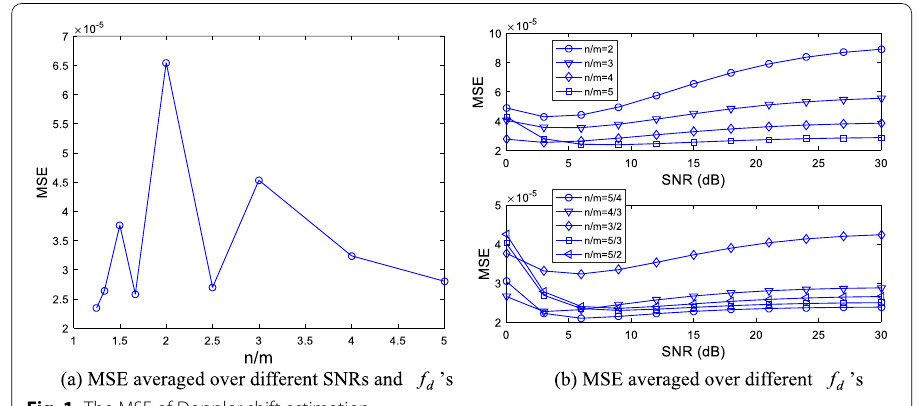
Fig. 1 The MSE of Doppler shift